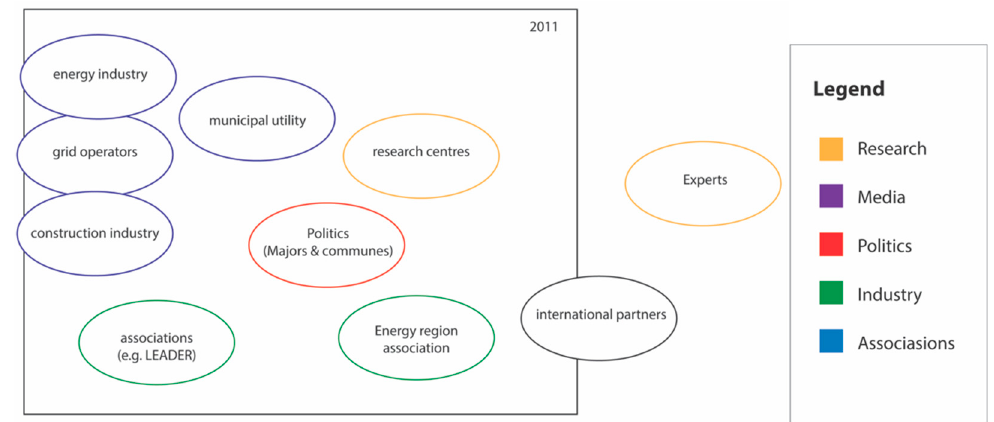
Figure 3. Aggregation of individual conceptual maps on the social subsystem in 2011 (authors ′ own elaboration).